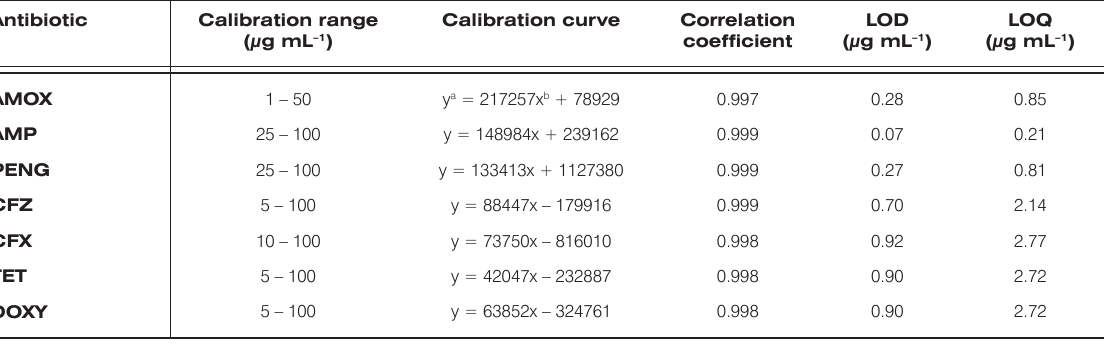
Table 4. Calibration ranges, calibration curves, correlation coefficients, limits of detection and quantification of the selected